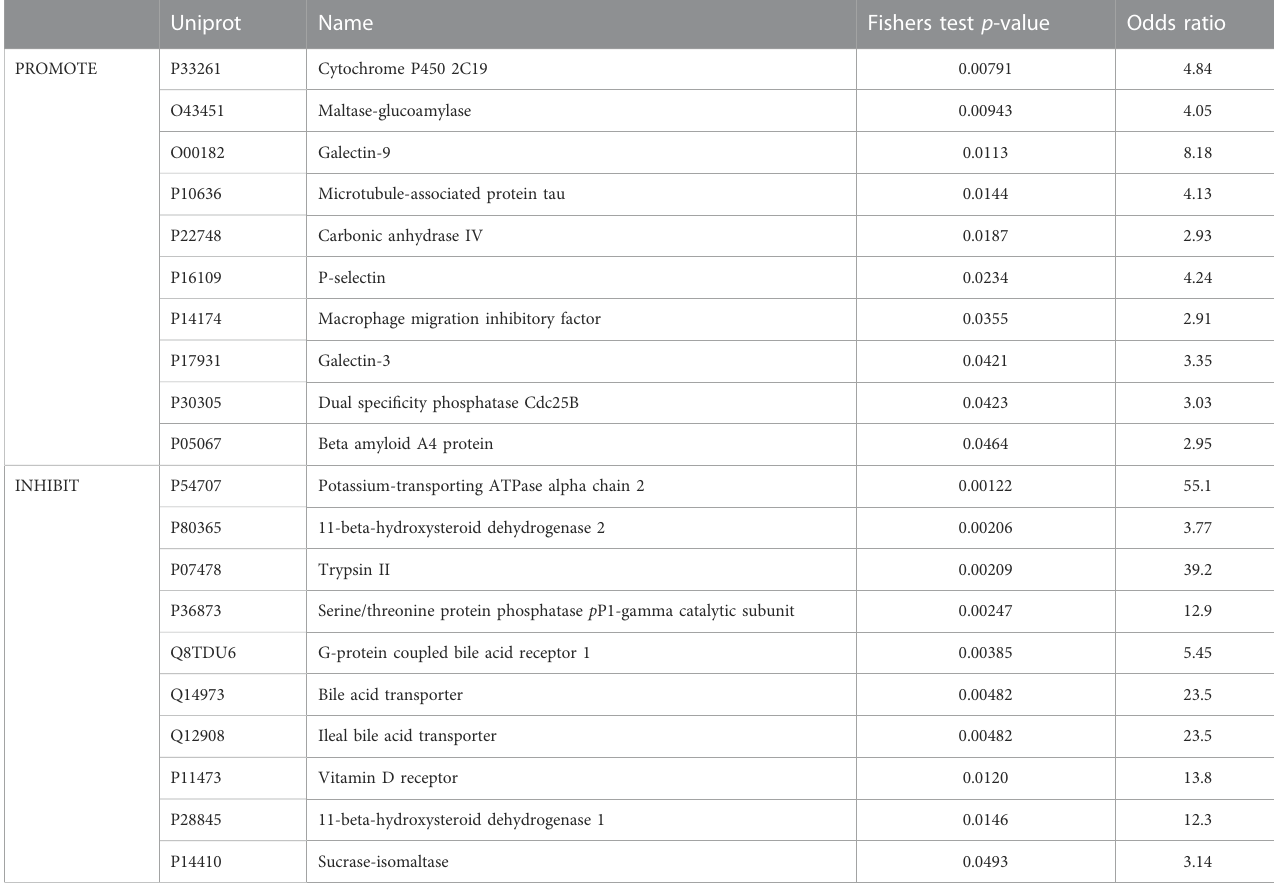
TABLE1Tenmostenrichedpredictedproteintargetsineitherpro-angiogenicoranti-angiogenicmetabolitesfromTCM.Predictedproteintargetsselectedandranked by Fisher ’ s exact test p